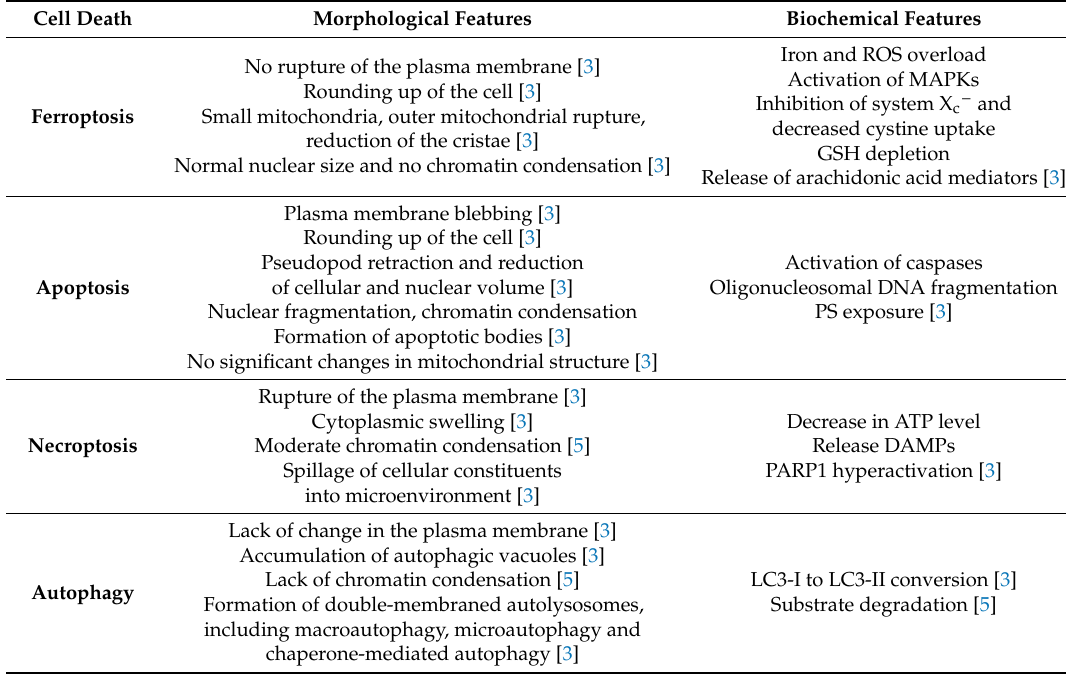
Table 1. The main morphological and biochemical features of regulated cell deaths (adapted from Xie et al., 2016 [5] and Lie et al., 2020 [3]). MAPKs , mitogen-activated protein kinases; GSH , glutathione; DAMPs , damage-associated molecular patterns; PS , phosphatidylserine; PARP1 , Poly [(ADP-ribose)] polymerase 1; LC3-I / II , Microtubule-associated protein light chain